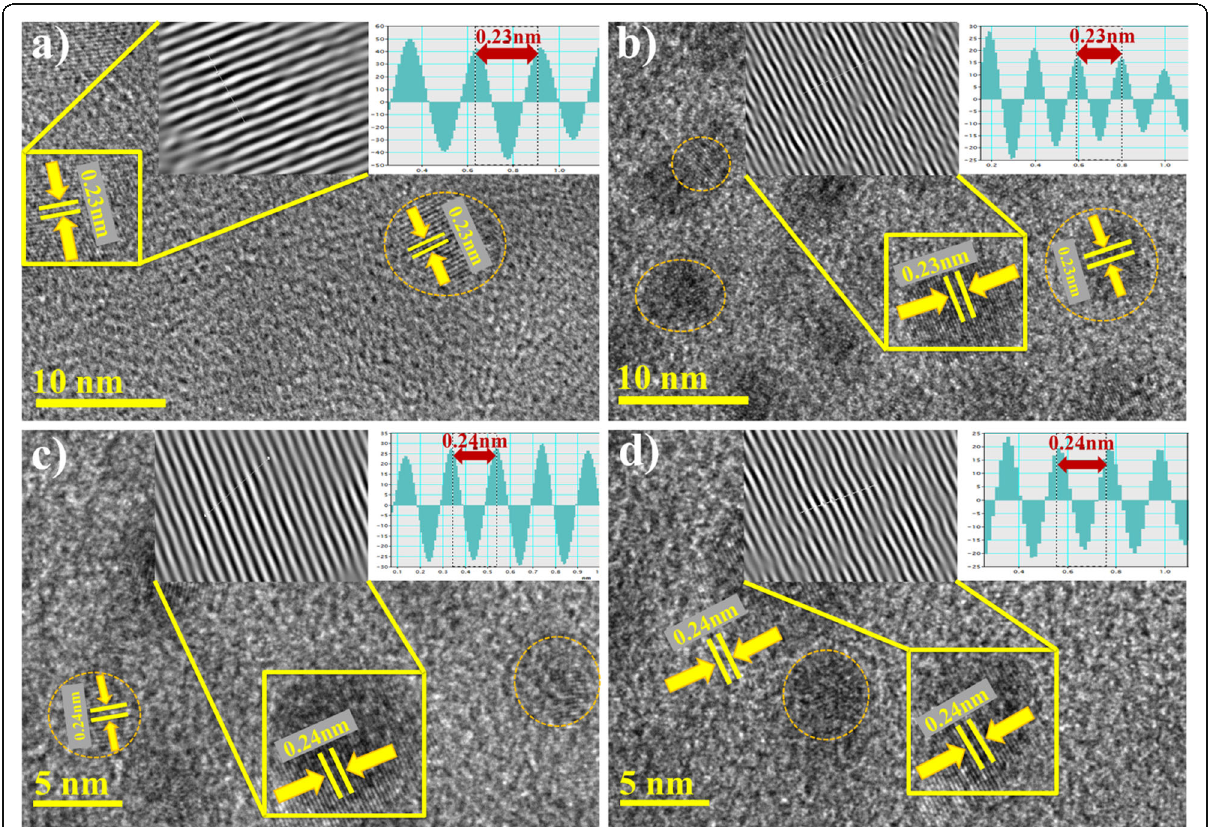
Fig. 6 a - d d-spacing from HR-TEM images of Ag-rGO ( a ) 0.025:1 ( b ) 0.050:1 ( c ) 0.075:1 ( d )